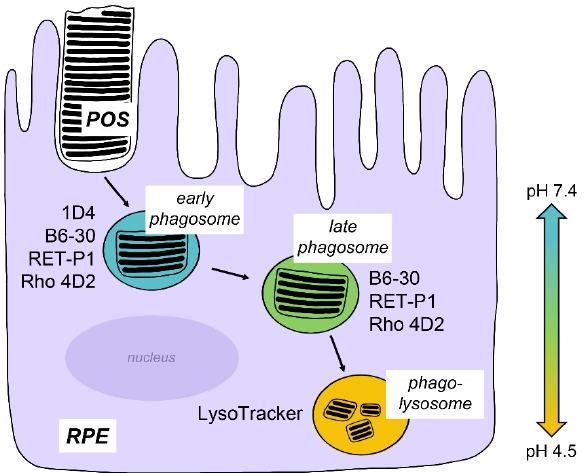
Figure 2. Detection of rod POS phagosomes depends on rhodopsin antibody usage. Freshly en- gulfed POS in early phagosomes before acidification retain both N-and C-terminal epitopes recog- nized by commercially available rhodopsin antibodies as indicated. Rhodopsin digestion proceeds in a step-wise fashion with early C-terminus cleavage resulting in loss of epitopes recognized by